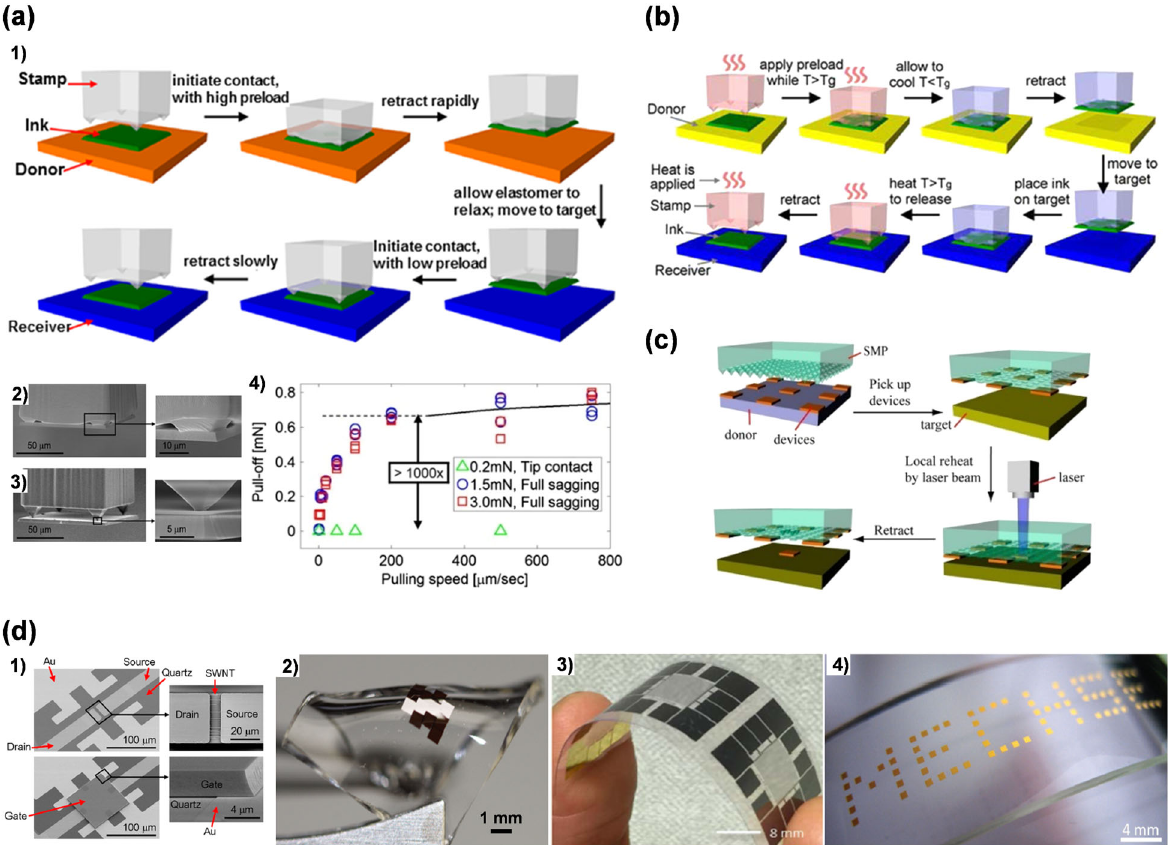
Fig. 8 Aphid-inspired transfer printing techniques: surface-relief assisted transfer printing. a Surface-relief assisted transfer printing technique. ( 1 ) Implementation of the aphid-inspired, surface-relief assisted transfer printing for deterministic assembly; SEM images of the ( 2 ) collapsed stamp and ( 3 ) recovered stamp with silicon platelets (3 μ m thick; 100 × 100 μ m) on their surfaces; ( 4 ) Force required to remove a microtip surface from the silicon, as a function of retraction speed for three different preload cases, simulating the steps of retrieval (1.5, 3 mN) and printing (0.2 mN) process. Adapted with permission from ref. 71 b Schematic illustration of the bonding/debonding between the SMP stamp surface and a substrate, where the recovery of the micro-pyramid structures is controlled by global heating. Reprinted with permissions